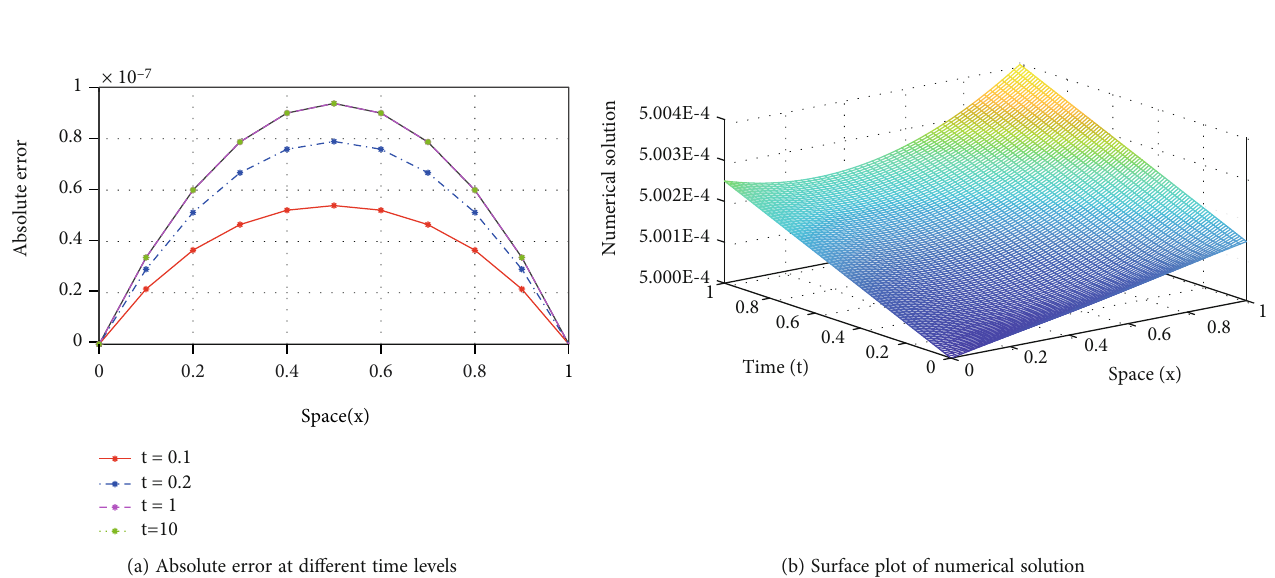
Figure 9: Error and solution pro fi le of Example 7 with N = 50 and Δ t = 0 : 01